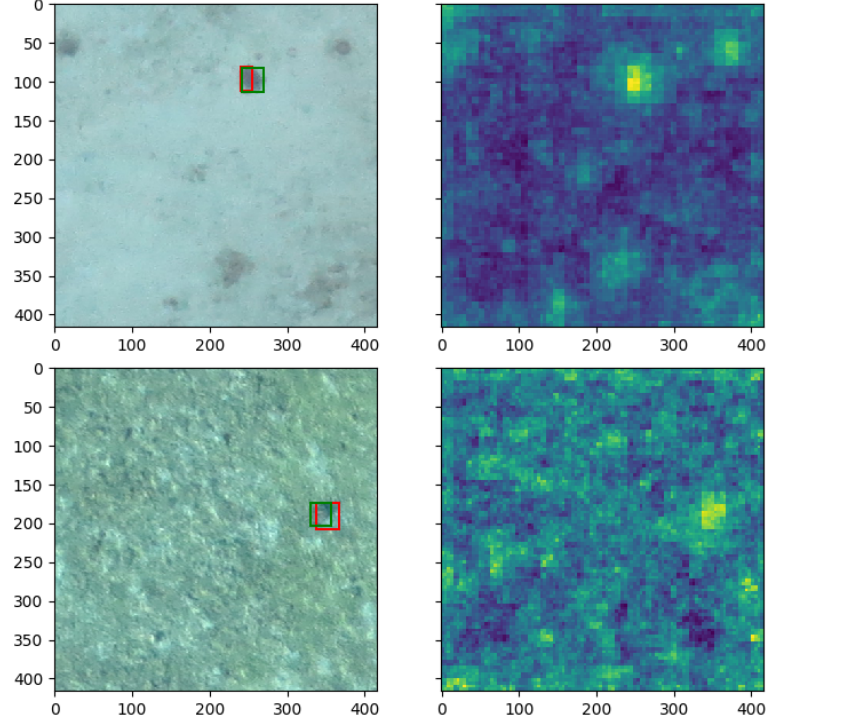
Figure 10. Example predictions ( left ) and their corresponding anomaly maps ( right ) from the Semmacape ( 2 first rows ) and Kelonia ( 2 last rows ) dataset. Rocks and waves have a higher anomaly score than water, using the appropriate anomaly threshold is important for the proposed regions to be